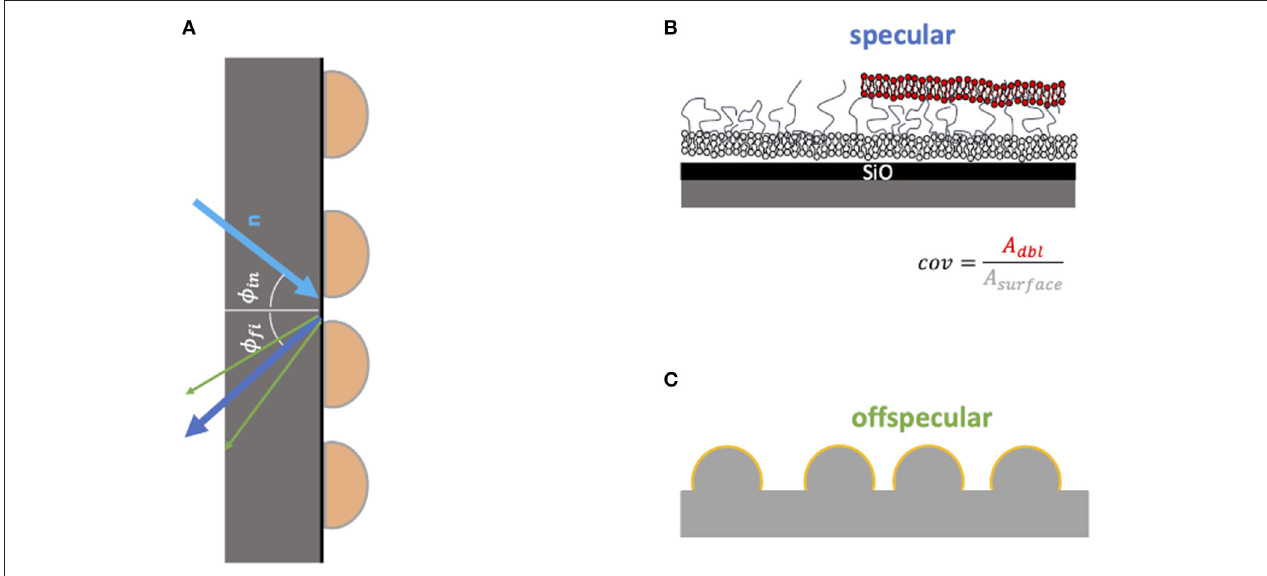
FIGURE 1 | Model of structures seen by the specular (A,B) and off-specular (C) NR signal. In the specular signal the layer structure in z direction is measured very precisely. However, it is more sensitive for the structure close to the silicon surface. From the fit of the specular data the coverage of the second bilayer can be estimated (top right panel). In the off-specular signal the roughness of the layer is measured (C) . If this signal appears one can conclude that the layer structure is not flat.